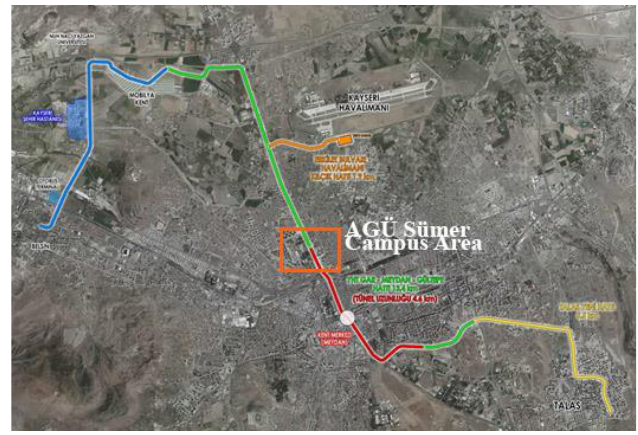
Figure 3 Satellite image showing AGÜ Sümer Campus location (orange rectangle) on Kayseri Ulaşım’s future network map. (Author based on Kayseri Ulaşım’s